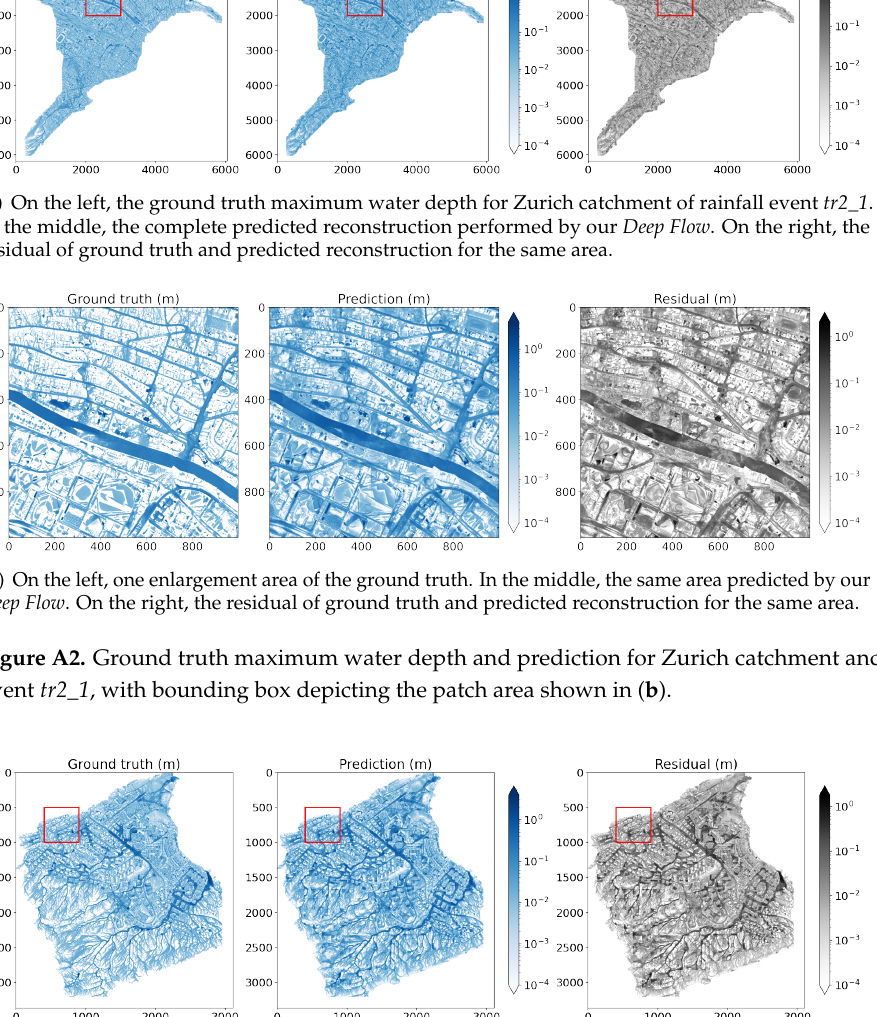
( a ) On the left, the ground truth maximum water depth for Lucerne catchment of rainfall event tr2_1 . In the middle, the complete predicted reconstruction performed by our Deep Flow . On the right, the residual of ground truth and predicted reconstruction for the same area.